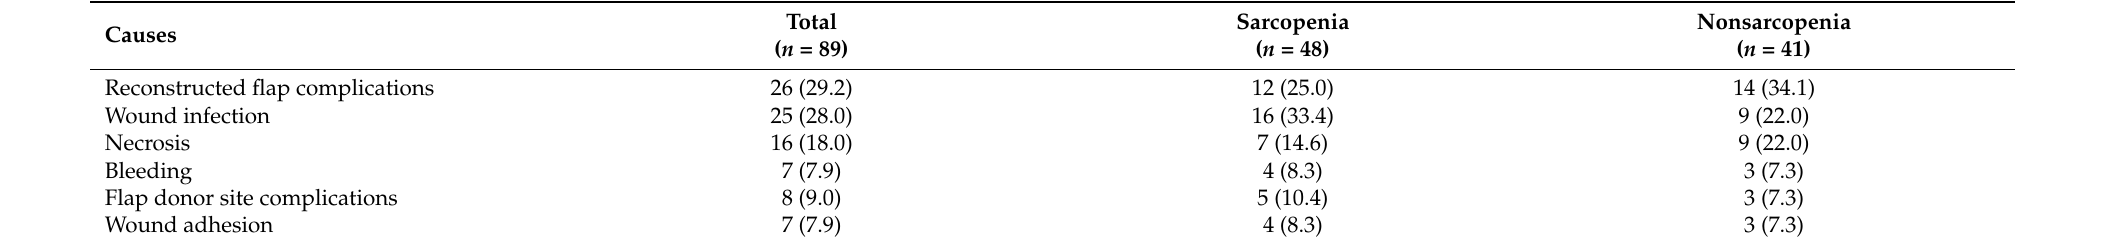
Table 3. Causes of reoperation within 30-day in oral cavity squamous cell carcinoma undergoing